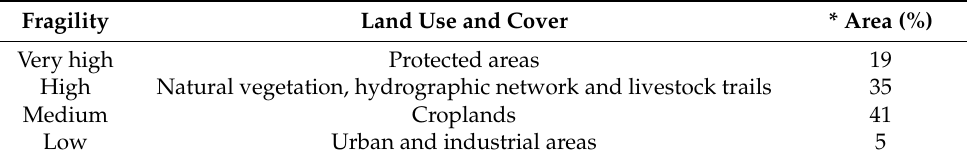
Table 1. Classification of environmental fragility. Fragility Land Use and Cover * Area (%) Very high Protected areas 19 High Natural vegetation, hydrographic network and livestock trails 35 Medium Croplands 41 Low Urban and industrial areas